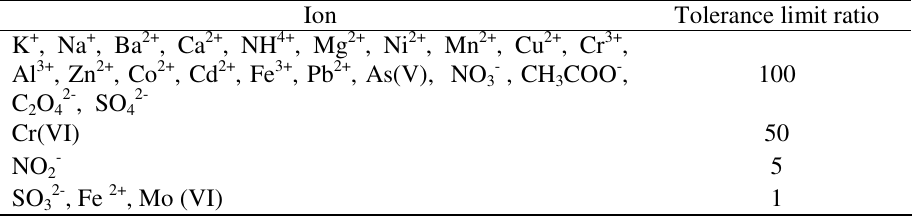
Table 3. Tolerance limits for diverse ions on the determination of 6.6×10 -5 mol L -1 iodide.